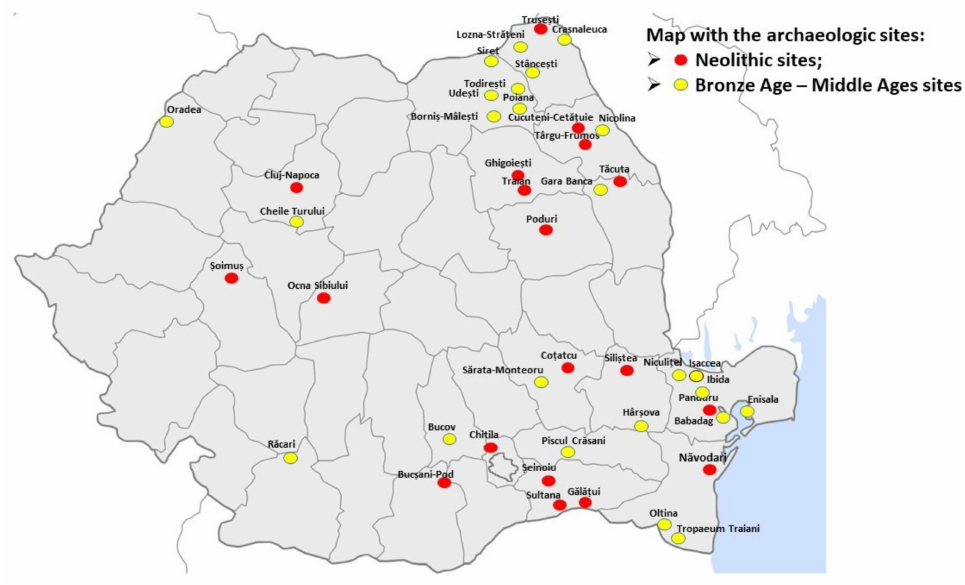
Figure 1. Map with the archaeologic sites where the samples were collected from